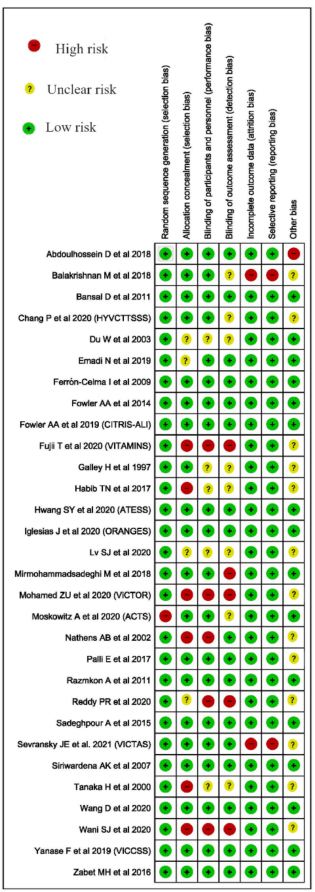
Figure 1. Cochrane ROB 2.0 of the included